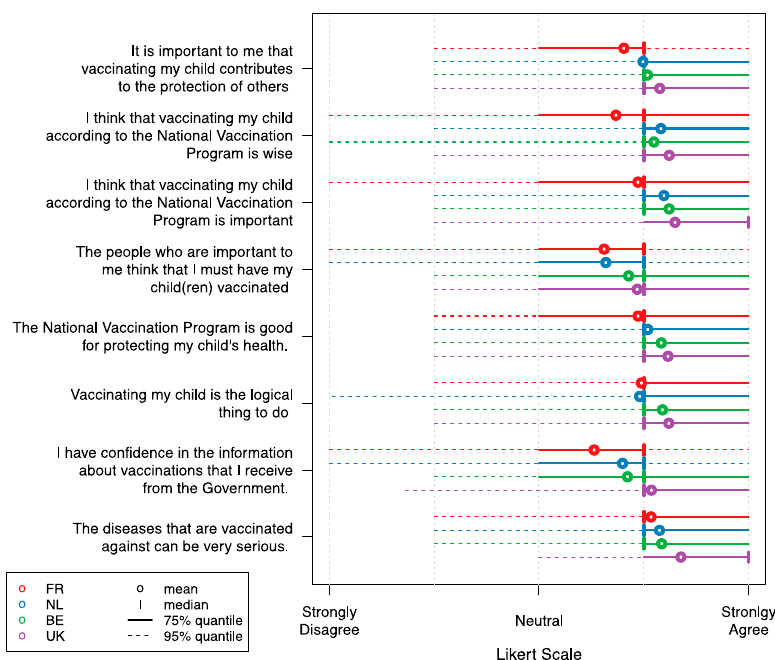
Figure 2. Likert scale responses for a selection of vaccination attitude statements in the ‘child’ group. Abbreviations: FR: France; NL: the Netherlands; BE: Belgium; UK: United Kingdom. Estimates for the Netherlands are derived from Hoogink et al. [31].